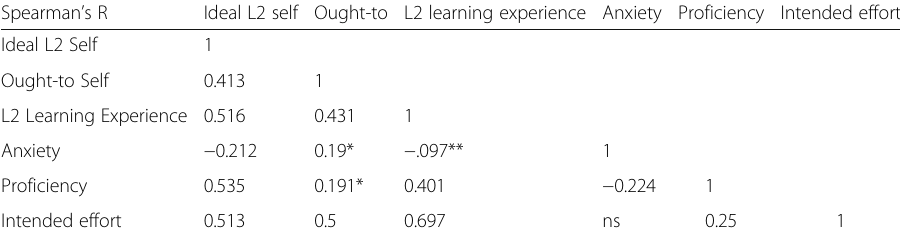
Table 3 Correlation statistics Spearman ’ s R